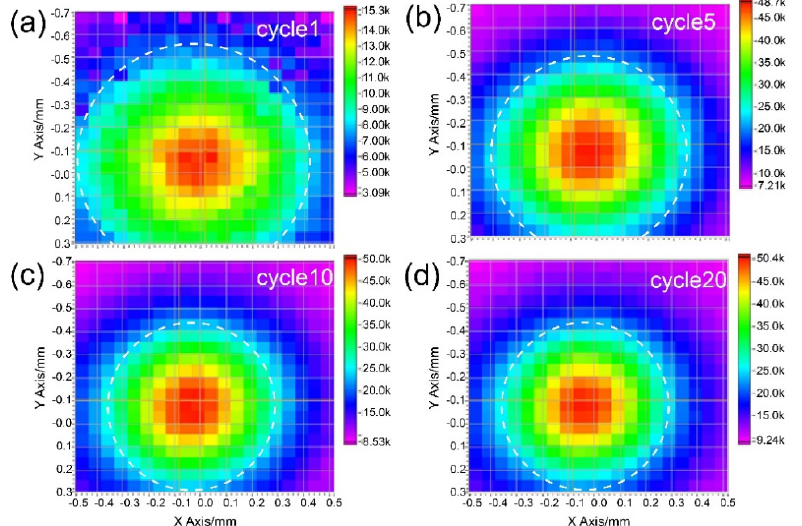
Figure 10. ( a – d ) Intensity maps of the pressure fields on the focus plane from the Fresnel lens-focused transducer with different cycle numbers of excited signal.